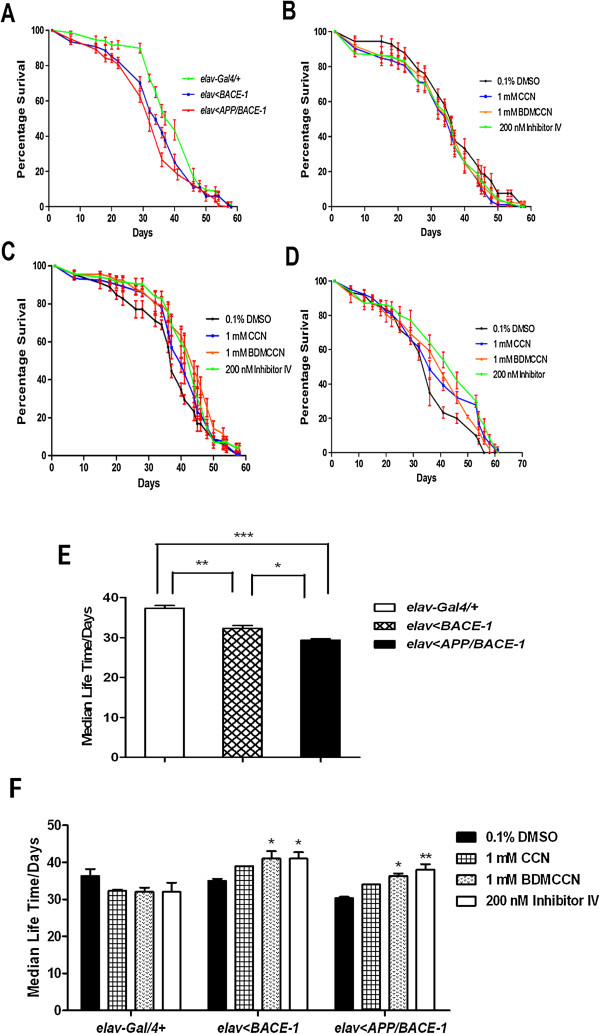
Effect of curcumin, bisdemethoxycurcumin, and β-secretase Inhibitor IV supplementation on longevity of elav-Gal4/+, elav < BACE-1, and elav < APP/BACE-1 flies. There was no significant difference in the longevity among three different genotype flies (A). Compound supplementation did not affect longevity of flies elav-Gal4/+(B), elav < BACE-1(C), and elav < APP/BACE-1(D). Median life time of three genotype flies cultured on standard medium (n = 200 flies per group. ***: p < 0.001, **: p < 0.01, *: p < 0.05) (E). Median life time of three genotype flies fed on curcuminoids and BACE-1 Inhibitor IV supplementation media (n = 200 flies per group. **: p < 0.01, *: p < 0.05) (F). Each bar represents standard error.